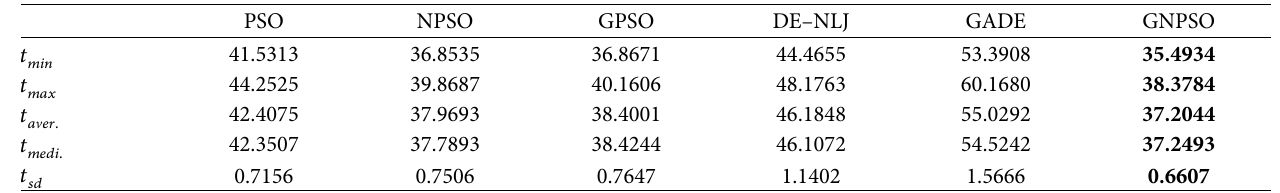
Table 19: Statistical results of computation time (sec) using different algorithms for Case 2: nonlinear wing vibration system with single control surface.